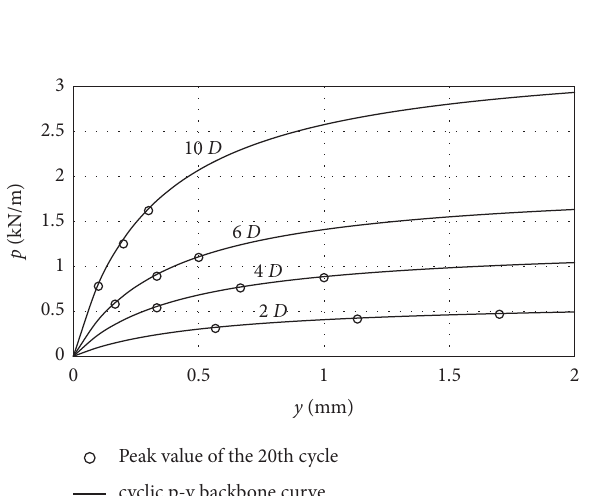
Figure 11: Peak values of the 20th cycle of p-y loops and their backbone curves at depths of 2 D , 4 D , 6 D , and 10 D ( D